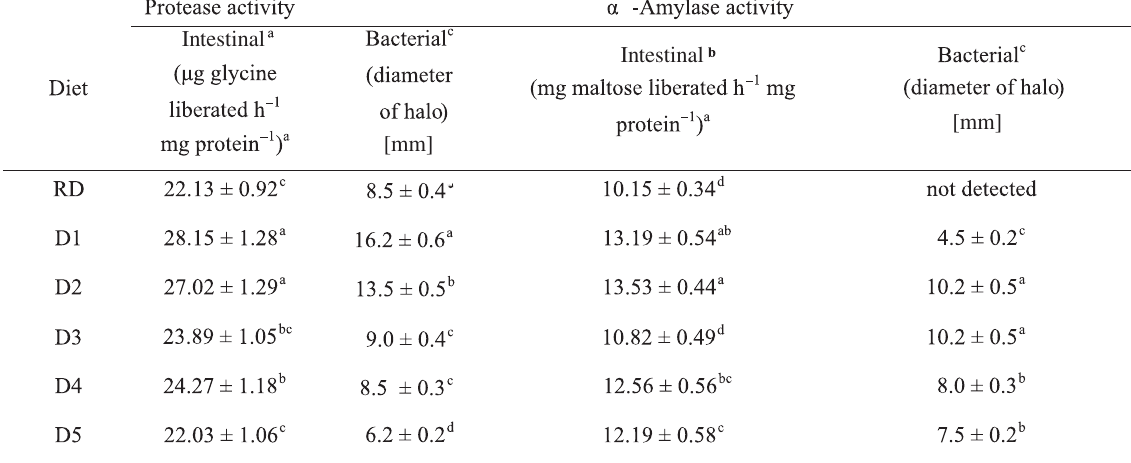
Protease and · -amylase activity in Labeo rohita fingerlings fed experimental diets for 75